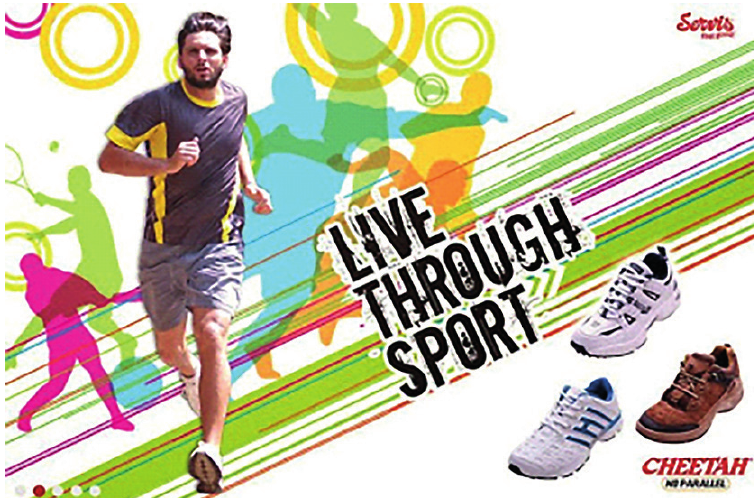
Figure 1. Advert of joggers Cheetah by Servis (source: The Nation,